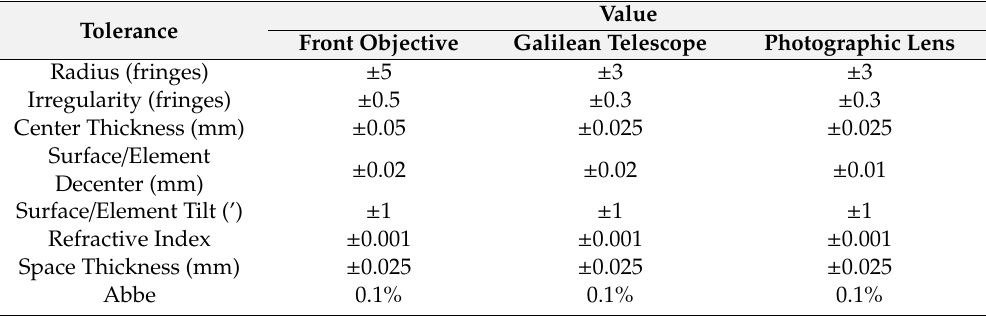
Figure 6. Worst offenders list for tolerance analysis. Δ MTF: the variation of MTF, where a negative value indicates a decrease. TTHI: tolerance for thickness or position in lens units. TSDX(Y): tolerance for standard surface X ( Y ) decentration in lens units. TEDX(Y): tolerance for element X ( Y ) decentration in lens units. TIRR: tolerance for standard surface irregularity. TABB: tolerance for Abbe number. The number after the type is the surface number as shown in Figure 3a. Table 3. System